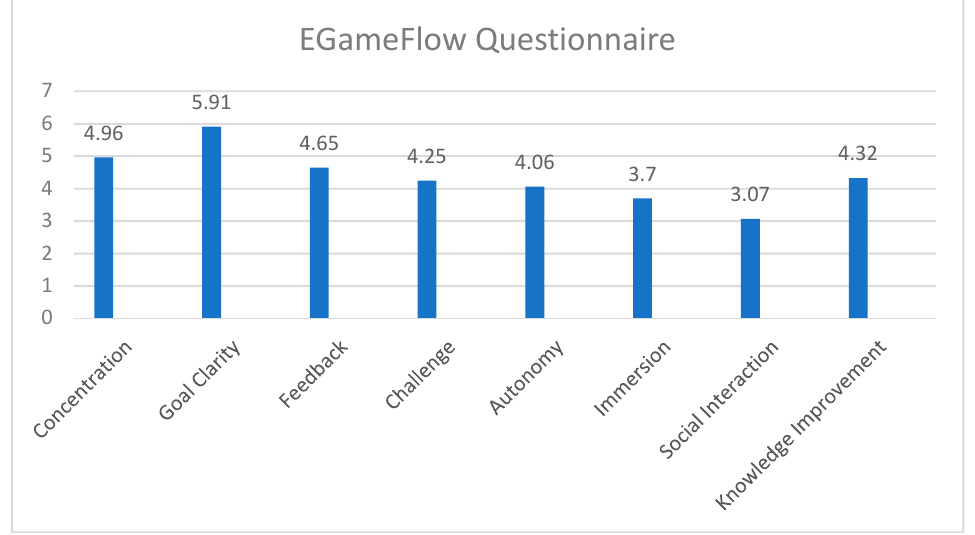
Figure 7. EGameFlow questionnaire mean values.